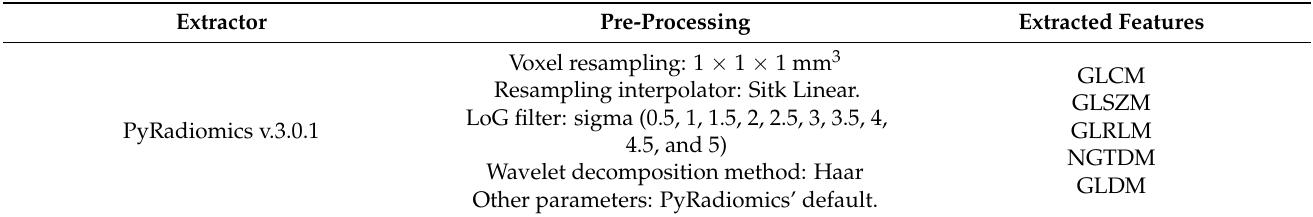
Table A1. Recap of the feature extraction parameters.